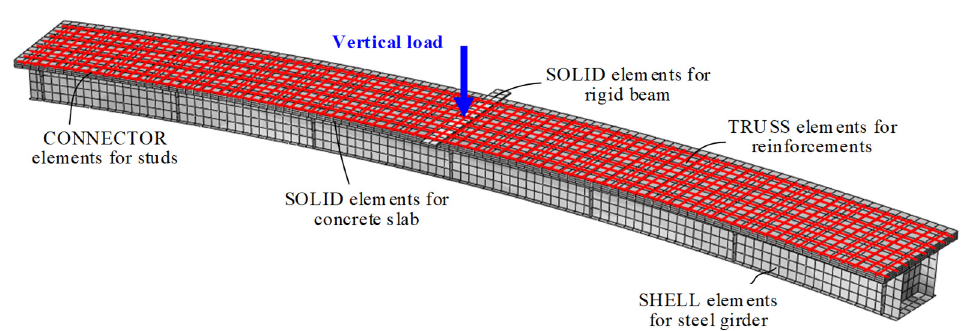
Figure 14. Finite element modeling scheme of CCB-2.